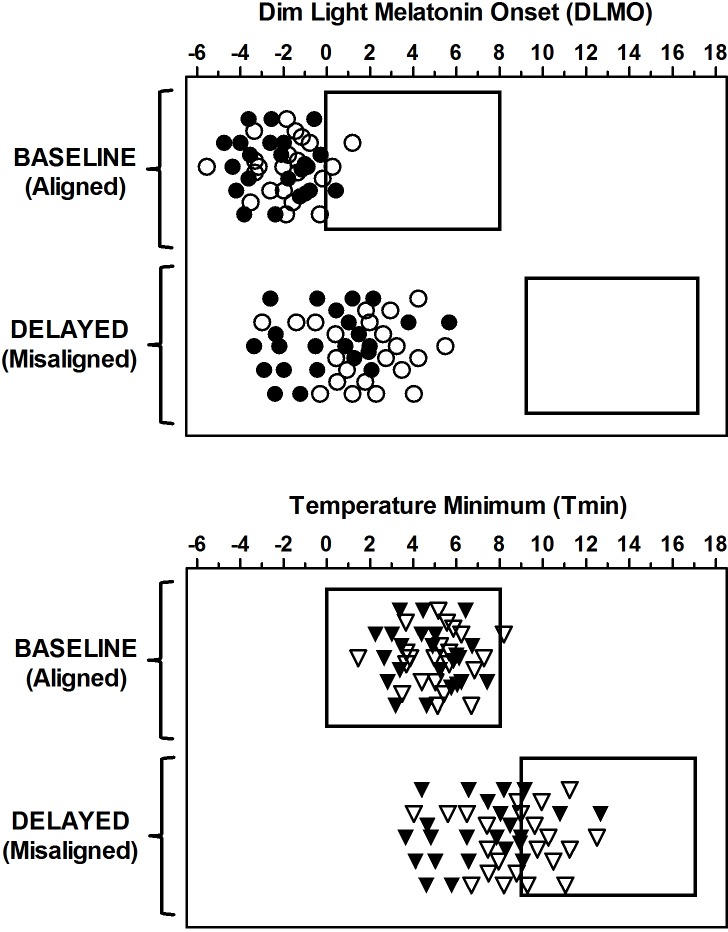
Dim light melatonin onset (DLMO) and estimated temperature minimum (Tmin) for each participant.DLMO was measured after the four baseline days on Chicago time (baseline, aligned) and after the three days on Japan time (delayed, misaligned). Rectangles show the timing of the sleep/dark periods. Top: Circles show the DLMO relative to the baseline bedtime, with 0 representing the timing of the start of the scheduled baseline sleep period. Bottom: Triangles show the Tmin relative to baseline bedtime. The Tmin was calculated as the DLMO + 7 h. Filled symbols represent African-Americans and open symbols are European-Americans. The DLMOs and Tmins were properly aligned to the sleep/dark periods during baseline (DLMOs before sleep and Tmins within sleep), but were misaligned relative to the sleep/dark period during delayed days. The vertical symbol placement is for visualization purposes and has no relationship to days.